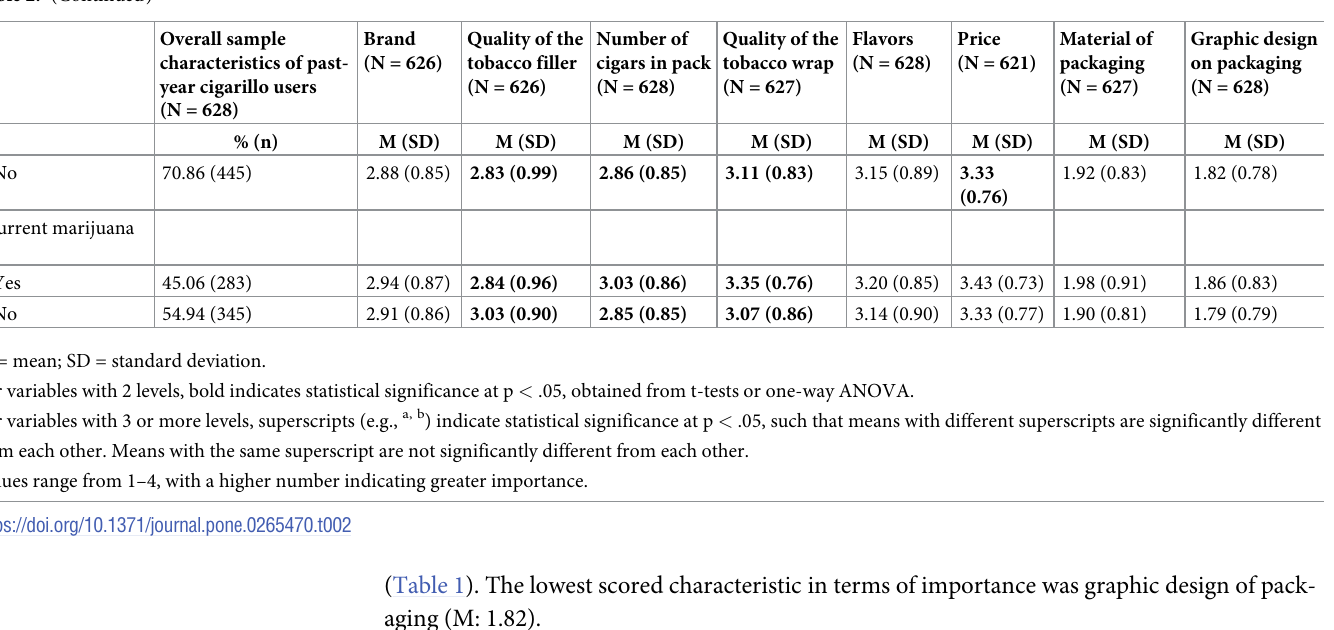
(Table 1). The lowest scored characteristic in terms of importance was graphic design of pack- aging (M: